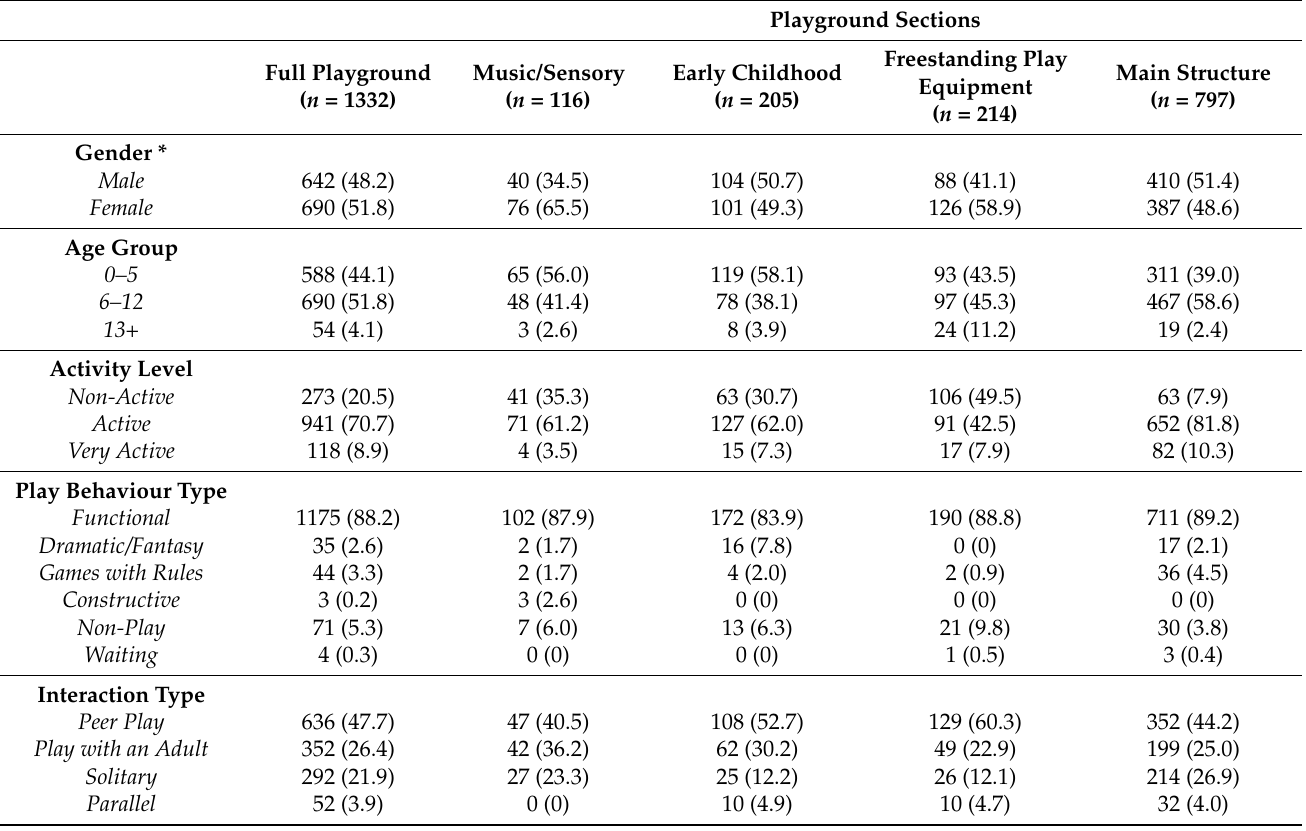
Table 2. Description of playground usage by observed gender, age group, interaction type and play behaviour type across the full playground and within each playground